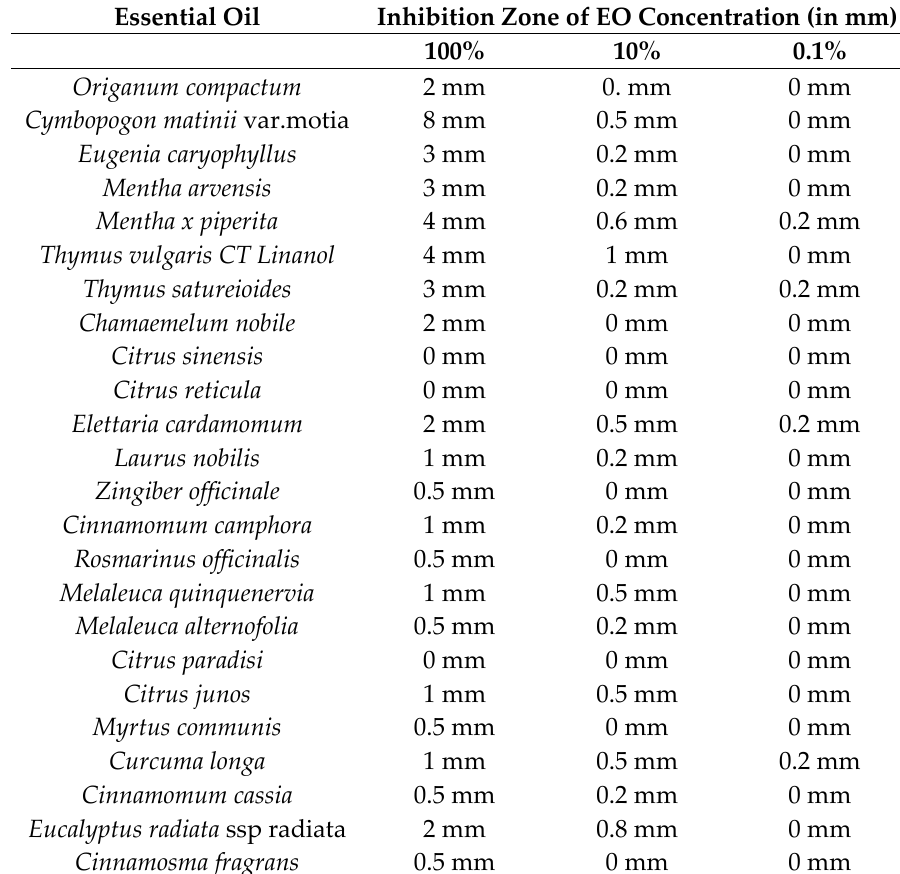
Table 1. Antibacterial activity of essential